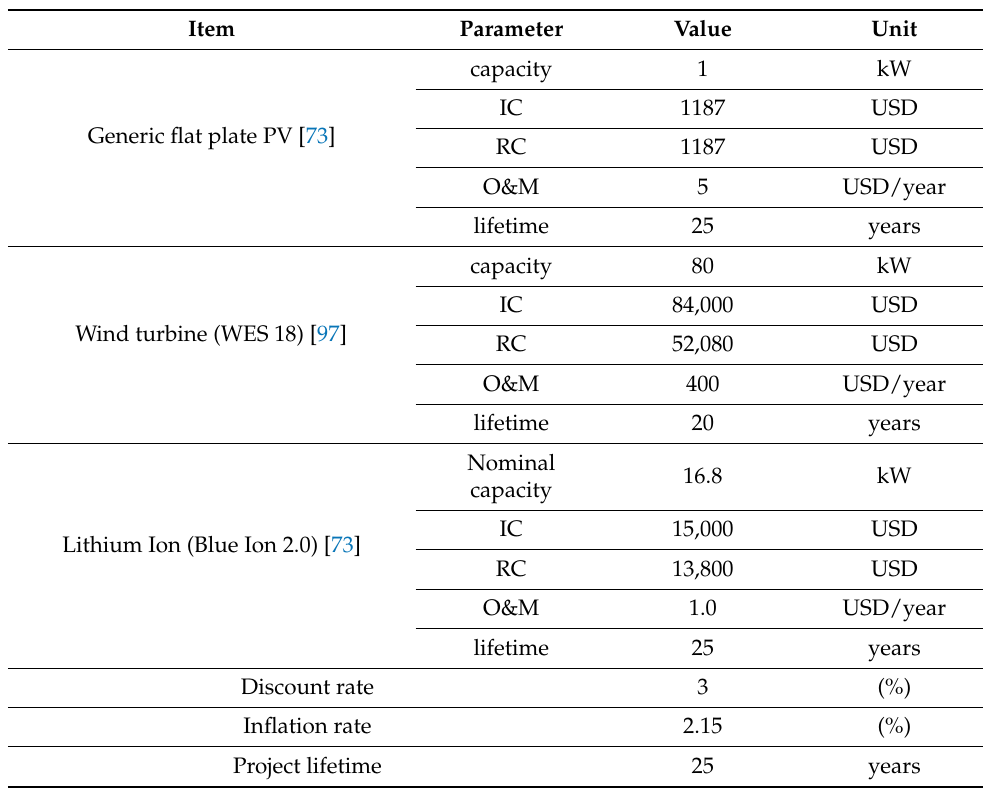
Table 3 lists various parameters of the proposed system components, including capacity, initial